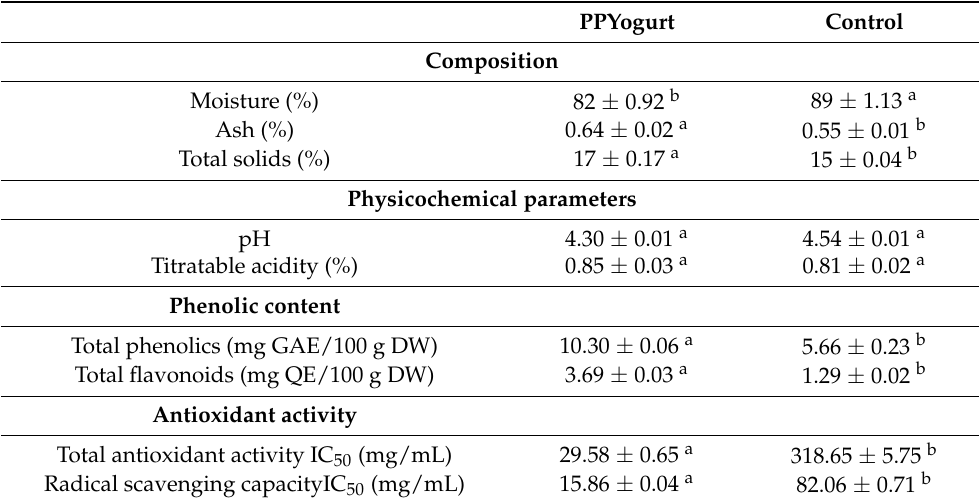
Table 4. Composition, physicochemical parameters, total phenolic content (TPC), total flavonoid content (TFC), and IC 50 ( µ g/mL) values found in the DPPH and phosphomolybdate assays for the yogurts fortified with